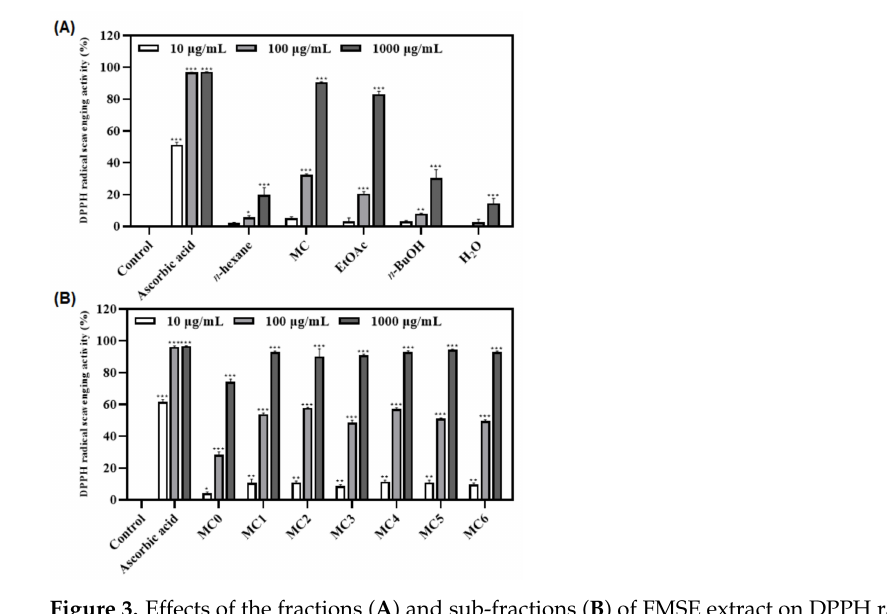
Figure 3. Effects of the fractions ( A ) and sub-fractions ( B ) of FMSE extract on DPPH radical scaveng- ing assays. The data are shown as the mean ± SD (n = 3) of three individual experiments. * p < 0.05, ** p < 0.01, and *** p < 0.001, compared with control (blank sample). Ascorbic acid was used as the positive